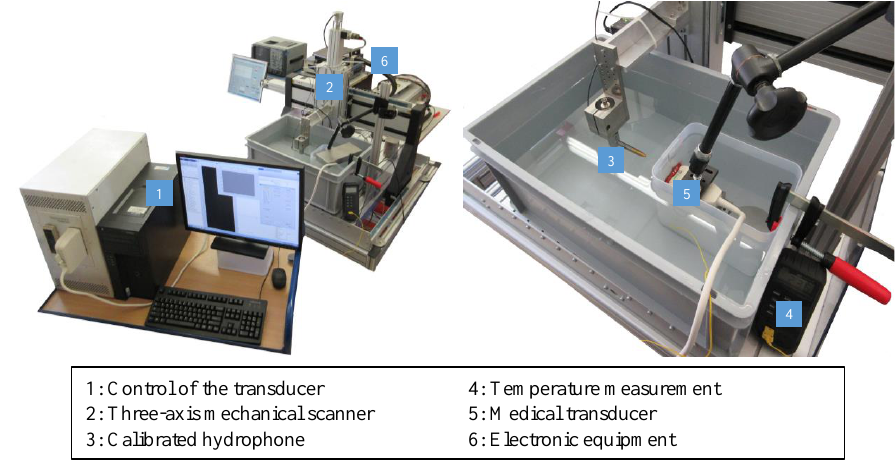
Figure 2. Hydrophone measurement